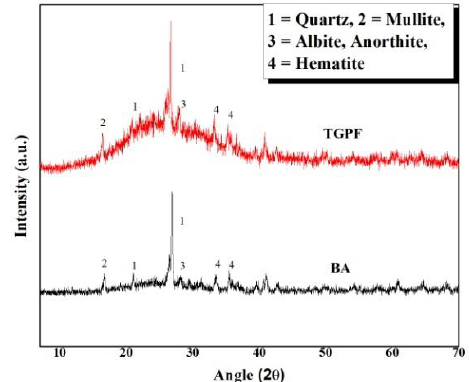
Figure 4. XRD pattern of bottom ash (BA) and TGPF.